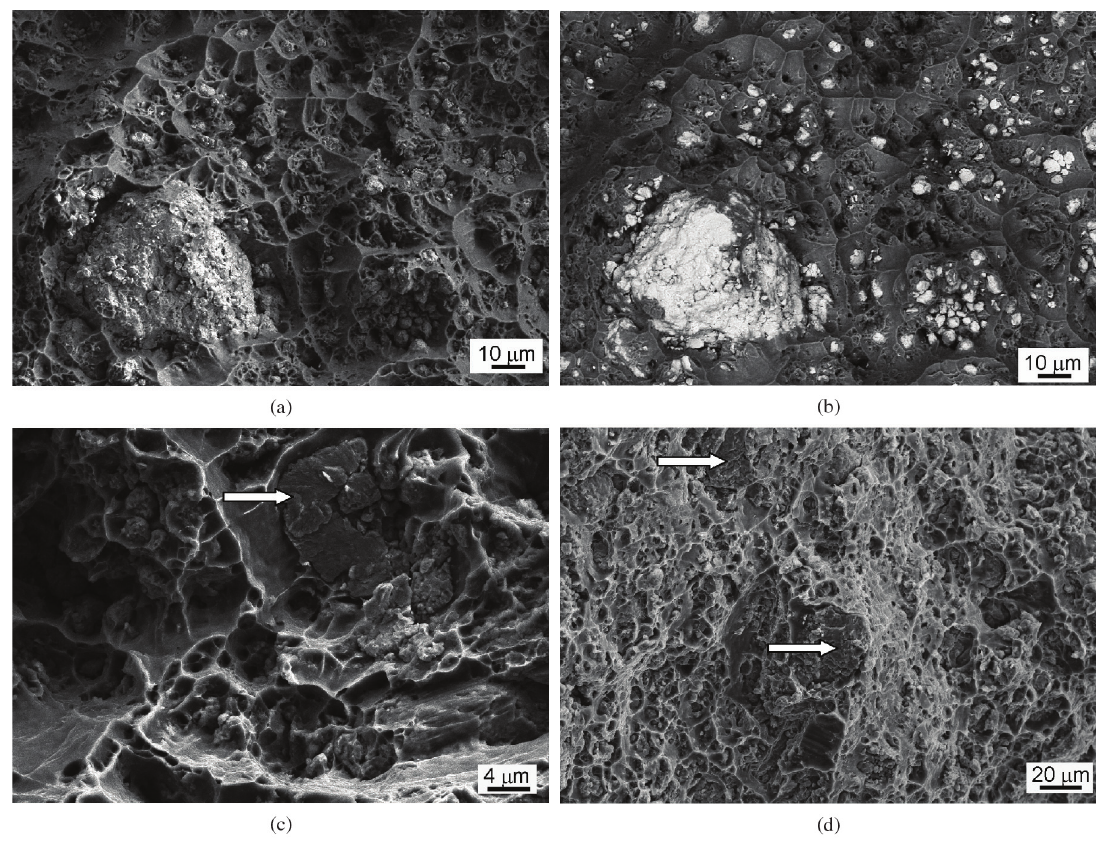
Figure 5. Fracture surface of the composite observed after tensile test at room temperature. (a), (b) and (c) 2 passes of ECAP by route A at room temperature, (d) 4 ECAP passes by route A at 150°C. (a), (c) and (d) micrographs obtained from secondary electrons (SE) and (b) micrograph obtained with backscattered electrons (BSE) where the bright zones corresponds to fine intermetallic powders or their the